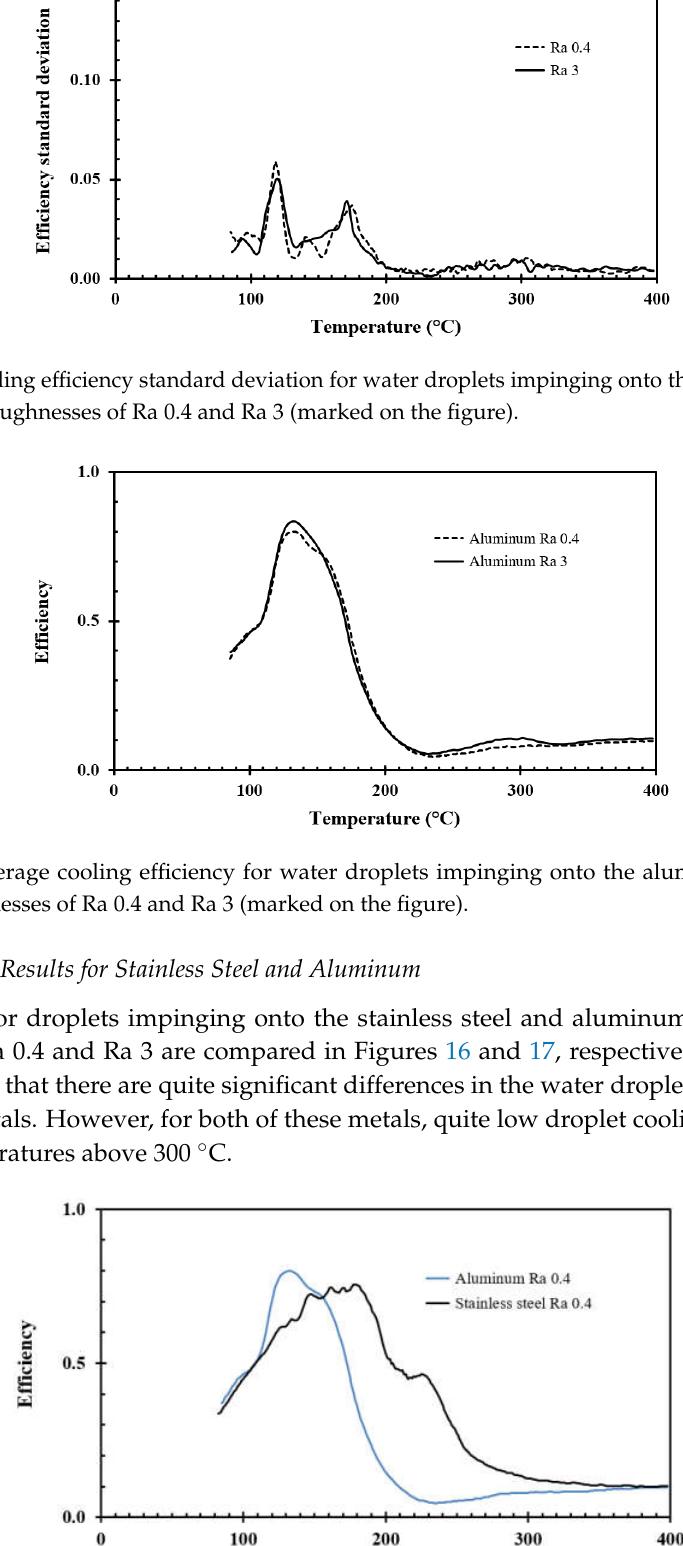
Figure 17. Average cooling efficiency for water droplets impinging onto the stainless steel and aluminum disc (marked on the figure) with a surface roughness of Ra 3. 5.4. NORSOK Requirements versus Spray Efficiency Applying a certain spray flux ̇ " (kg/s·m 2 ) with a cooling efficiency of  to a hot surface above the boiling point of the liquid, the cooling potential is given by: ̇ " =  ∙ ̇ " ∙ ∆  (W/m  )